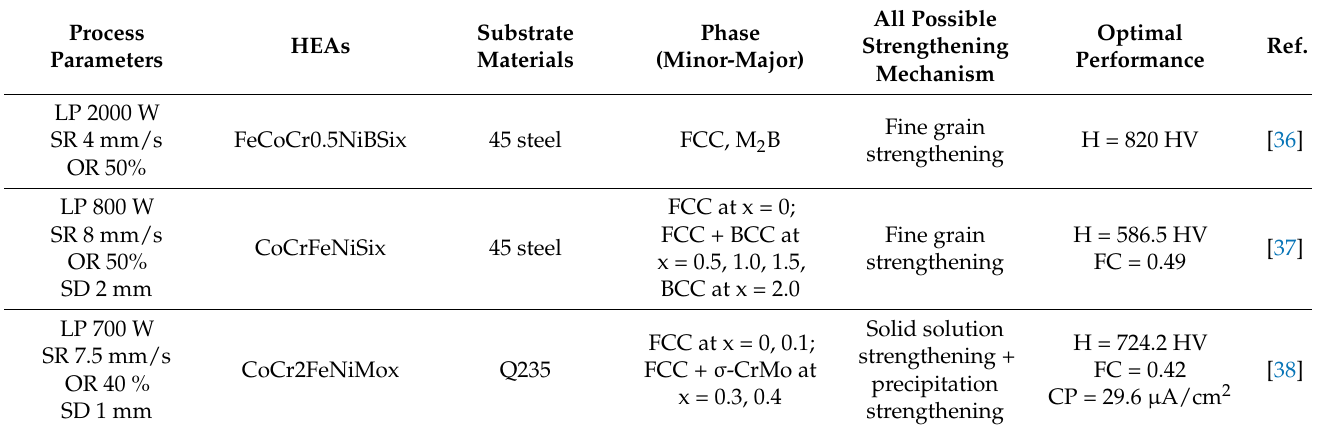
Table 1. Overview of process parameters, HEA compositions, microstructures and major